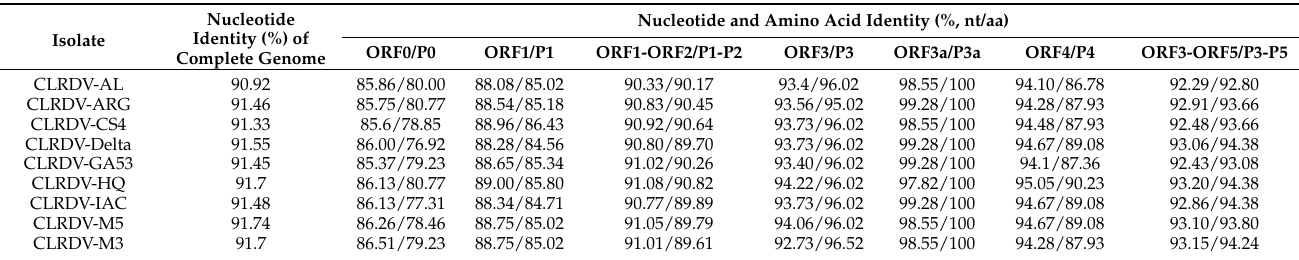
Table 1. Pairwise nucleotide and amino acid sequence identities of the viral open reading frames for the Henan isolate and isolates of cotton leafroll dwarf virus calculated using Sequence Demarcation Tool software v1.2.